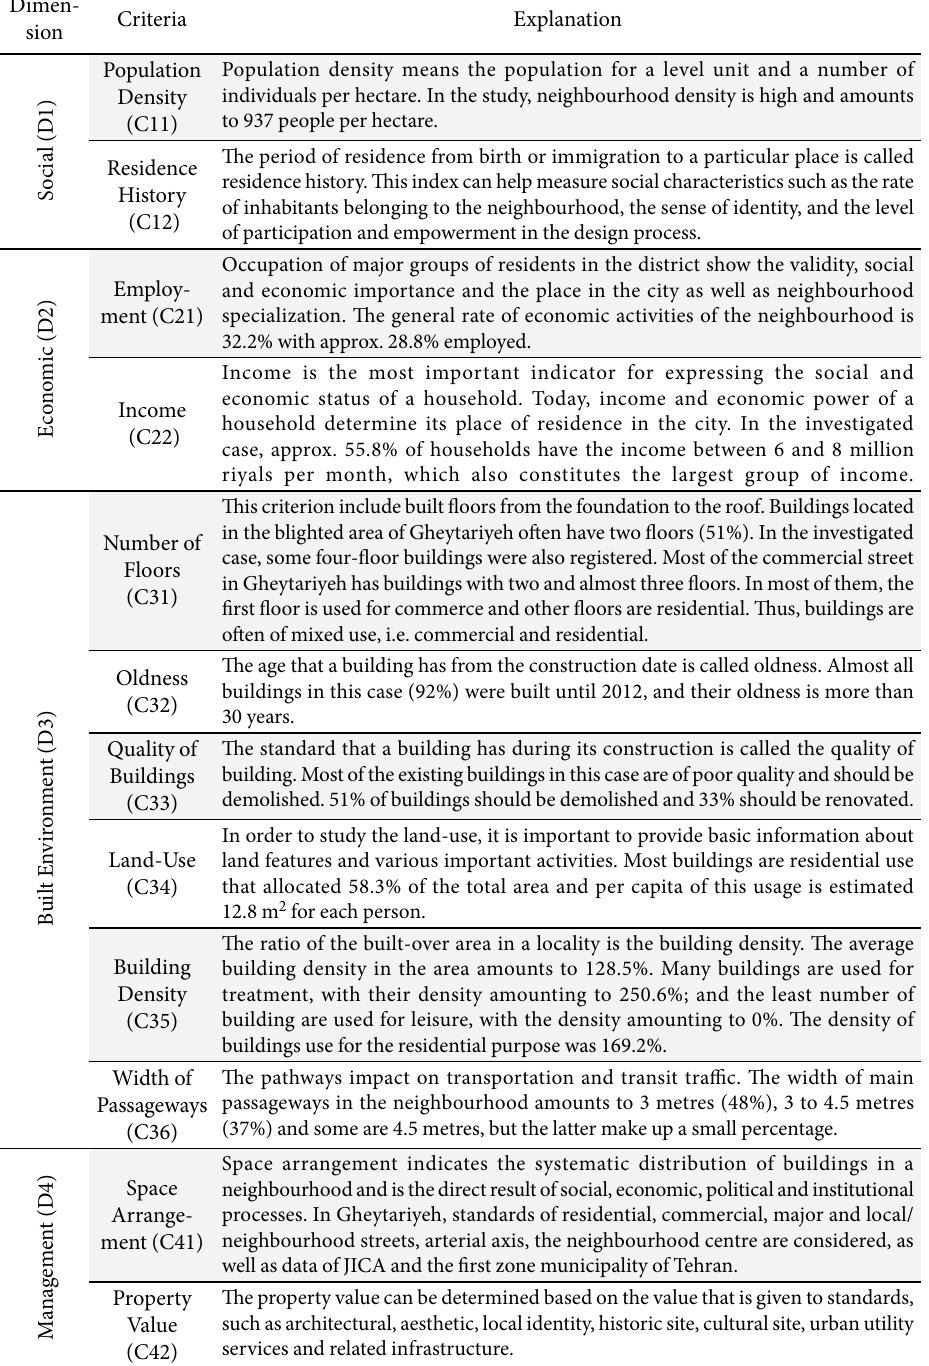
Table 1. Influence relationship of dimensions and criteria for leisure space performance